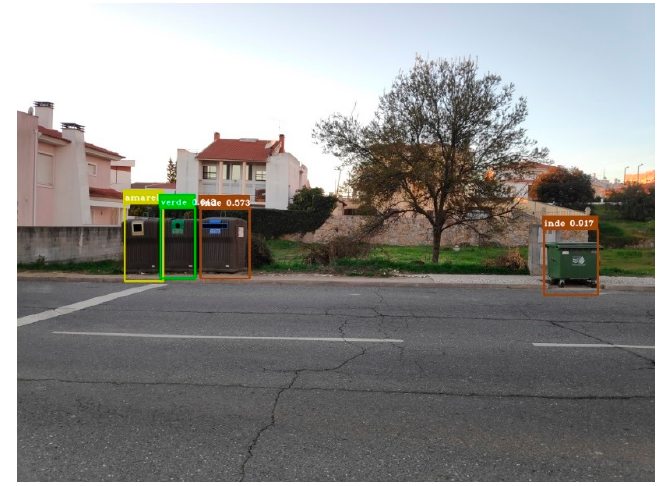
Figure 7. A false positive detection example.